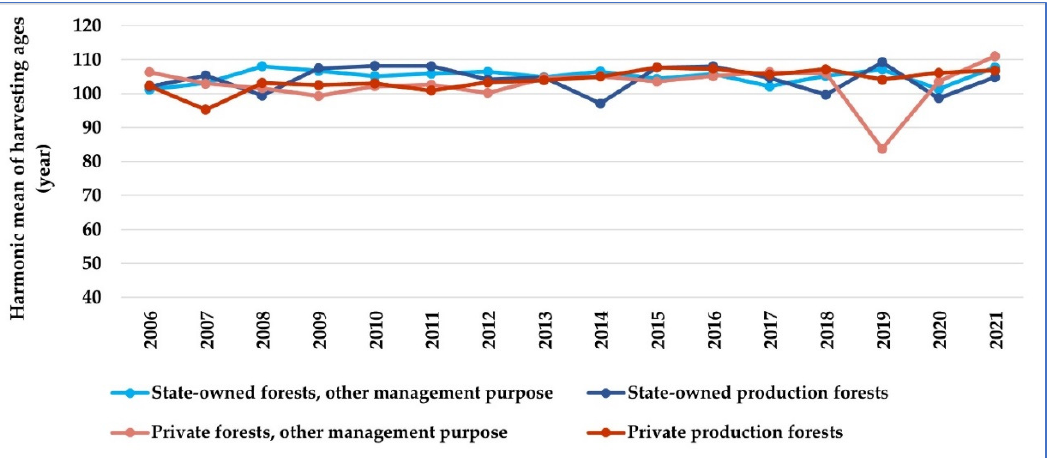
Figure 5. Harmonic mean of harvesting ages (weighted by the area under harvest) of European beech ( Fagus sylvatica ) stands in the period between 2006 and 2021 grouped by management purpose and ownership.